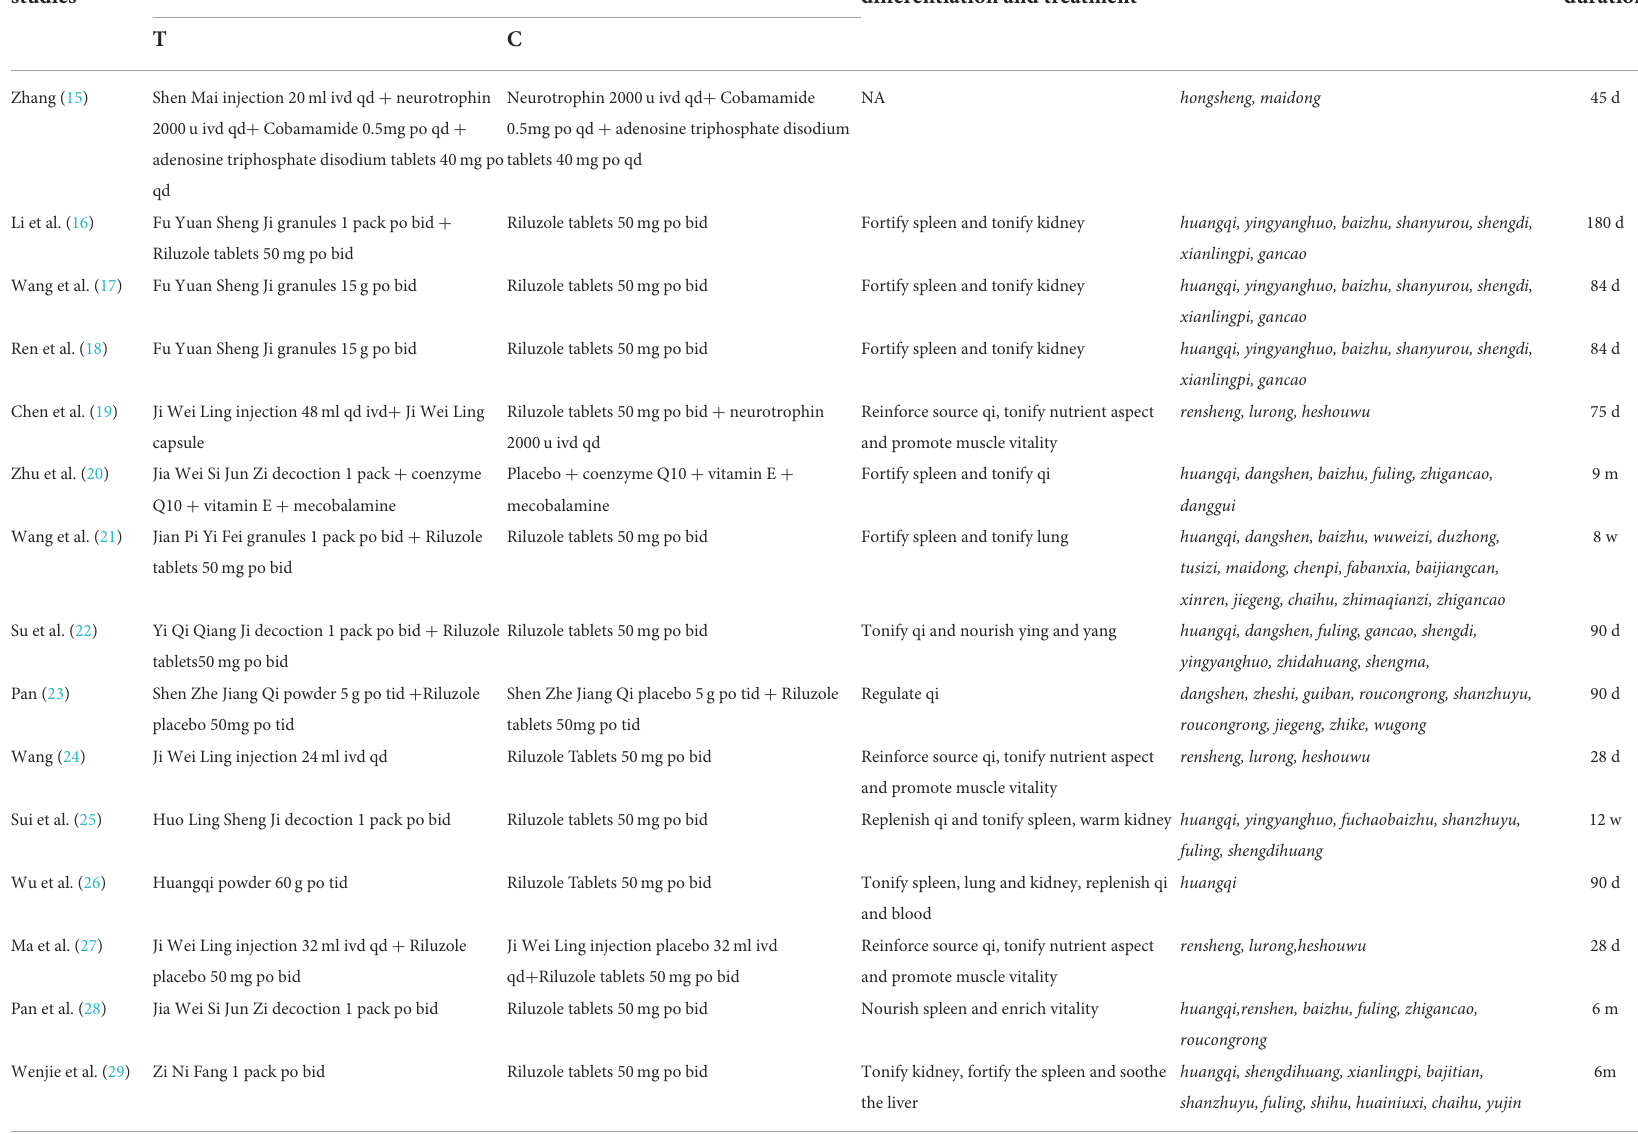
TABLE 2 Details of interventions in the included